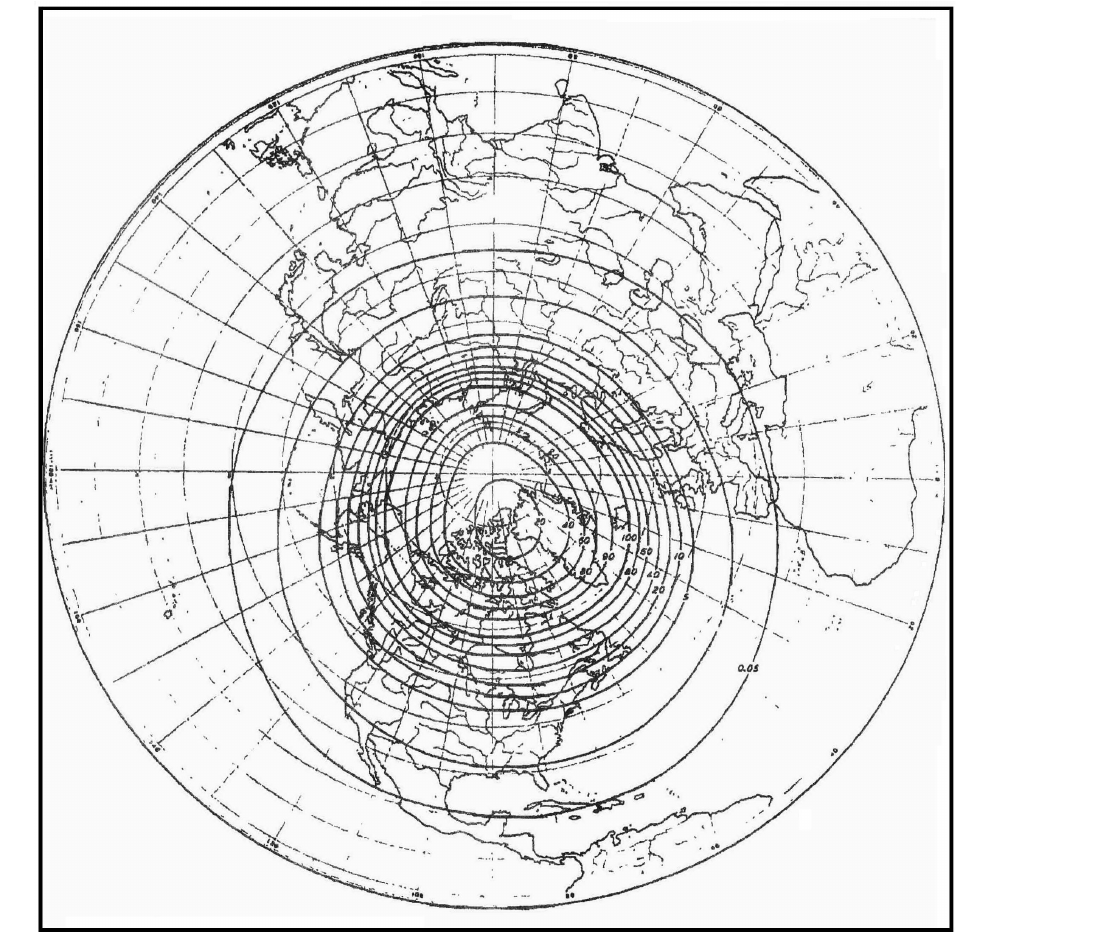
Figure 3. Drawings of isochasms in the Northern Hemisphere according to Vestine